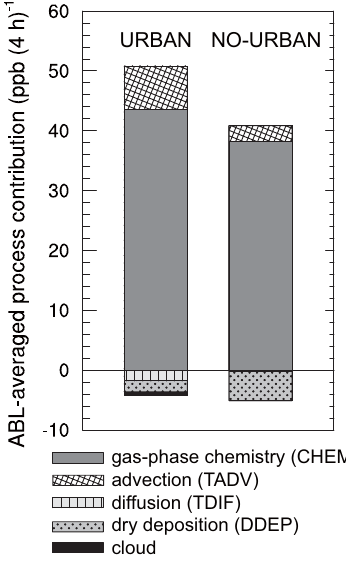
Fig. 6. Time-integrated contributions of individual processes aver- aged in the ABL over the urban analysis area for the period from 12:00 to 16:00 LT in the URBAN and NO-URBAN